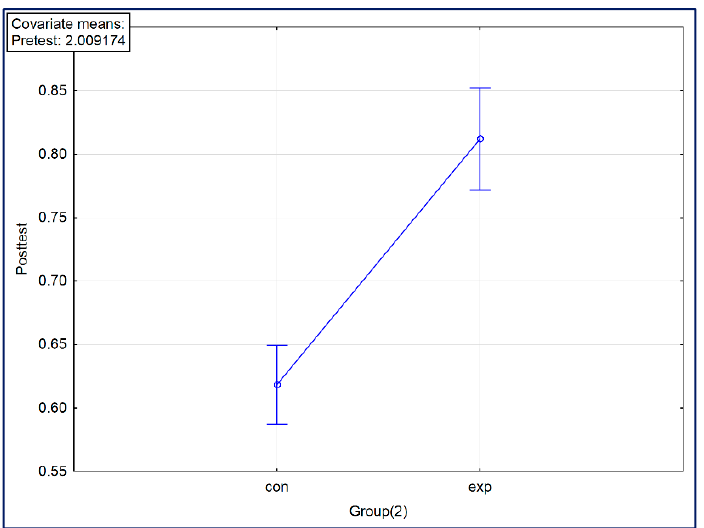
Figure 5. Graph of point and interval estimation of the mean for the posttest with the pretest con- trol.